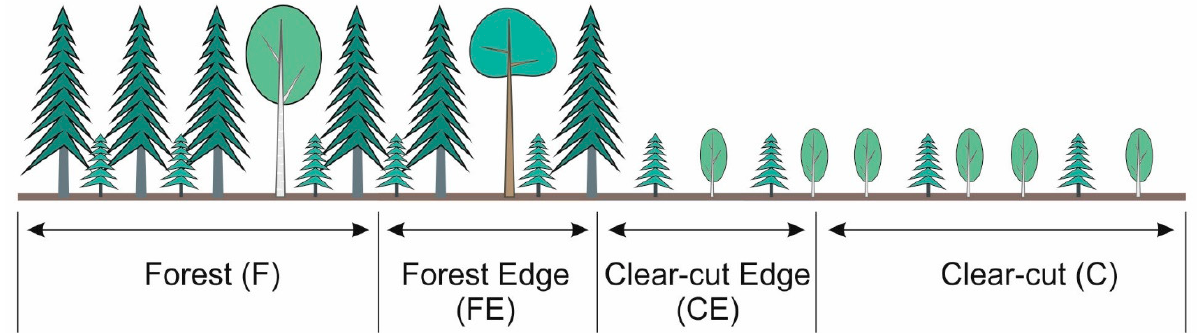
Figure 2. Ecotone complex arrangement and zone notations. See text for explanations.